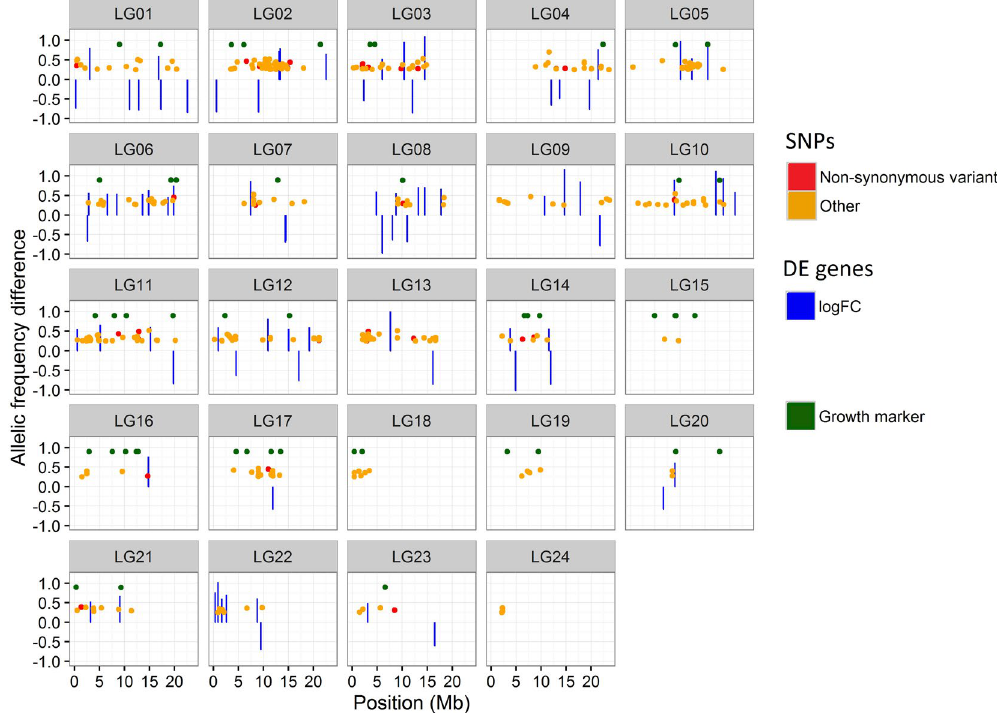
Figure 3. SNPs with differential frequencies along the turbot genome. SNPs showing allelic frequency differences between fast- and slow-growing turbot are shown in red (non-synonymous mutations) or orange (any other type of mutation) in the different chromosomes of the turbot genome. The fold change of those genes with FDR corrected p-values < 0.3 are shown in blue and the position of genetic markers previously found associated with growth traits are shown in